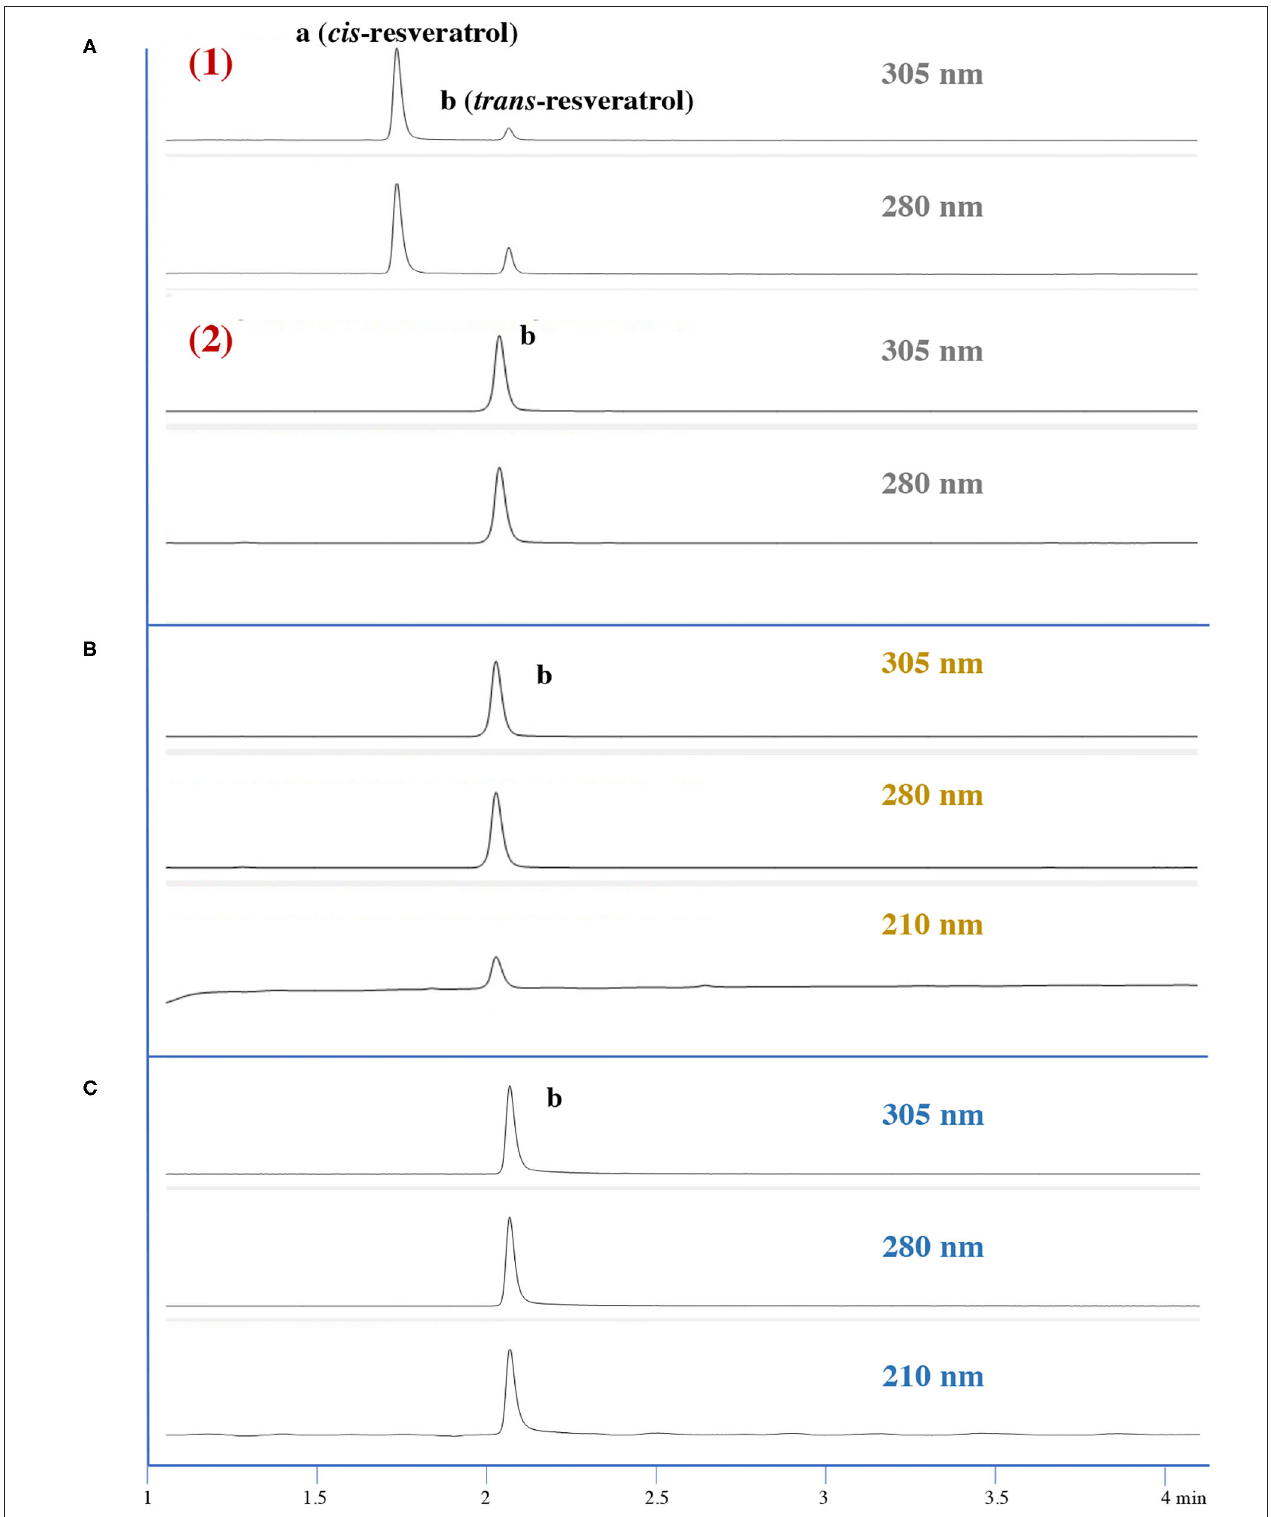
FIGURE 2 | UV chromatographs of (A) trans- and cis- resveratrol (RSV); (B) RSV capsules. Peak a, cis- RSV, Peak b, trans -RSV. (A) -(1) UV chromatographs of solution A as described in section RSV Purity and Content Uniformity: Method Validation under 305 and 280 nm; (A) -(2) UV chromatographs of solution B under 305 and 280nm; (B) UV chromatographs of the RSV original material under 305, 280, and 210nm; and (C) UV chromatographs of the RSV capsule under 305, 280, and 210nm.